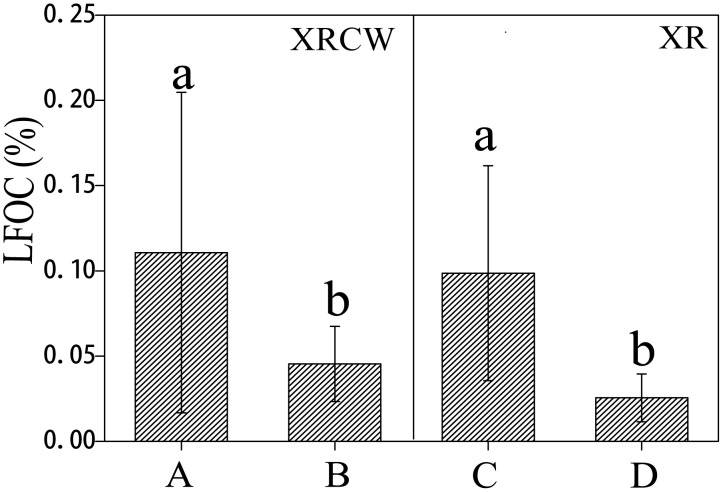
The spatial distribution of light fraction organic carbon (LFOC).Bar plots showing the spatial distribution of light fraction organic carbon (LFOC) in the Xinxue River (XR) and Xinxue River Constructed Wetland (XRCW). A = upstream location of XRCW; B = downstream location of XRCW; C = upstream location of XR; D = downstream location of XR. Bars sharing the same lowercase letter (a or b) are not significant at α = 0.05 (Duncan test).